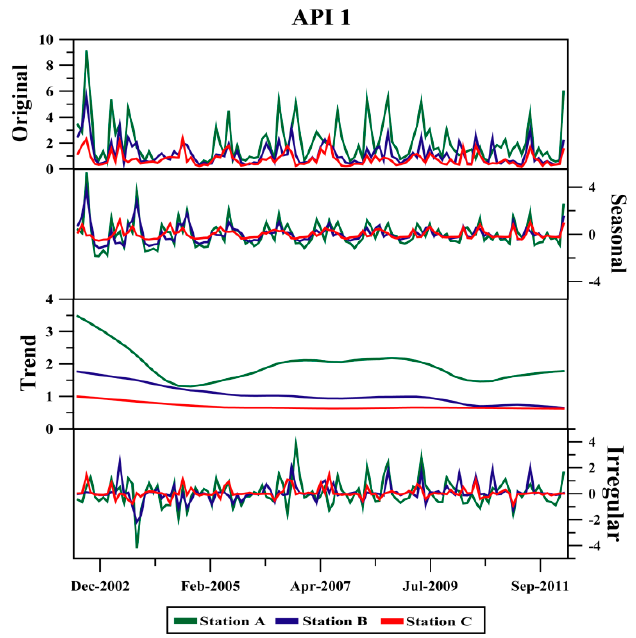
Figure 7. Decomposition plots of MERIS water constituent API 1 at the three Stations by stl.fit(). Table 2. Percentage of data represented within the interquartile range (IQR) for the time series components for the MERIS products water leaving reflectance ( ρ w ) at 443, 490, 510 and 560 nm and for the Algal Pigment Index 1 (API 1) at Stations A, B and C (dominant components are highlighted in bold).